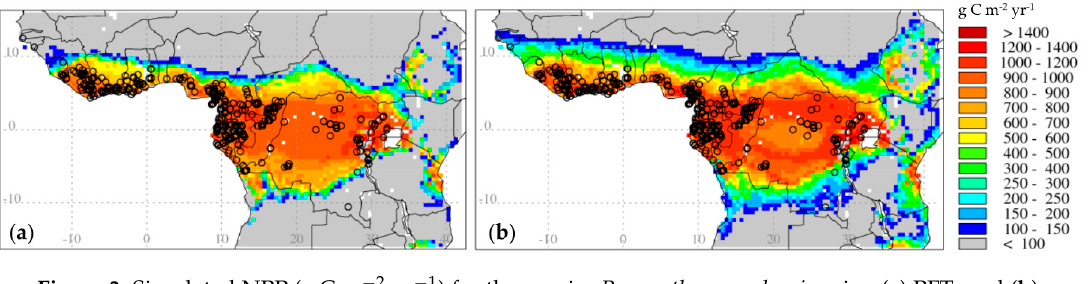
Figure 3. Simulated NPP (g C m − 2 yr − 1 ) for the species Pycnanthus angolensis using ( a ) PFT- and ( b ) species-specific traits. The grey color corresponds to simulated NPP values below the 100 g C m − 2 yr − 1 threshold and the black circles to occurrence data [55,56]. Simulations were obtained with CRU historical climatic data for the reference 1980–1999 period. Table 4. Observed species occurrences, species distribution area (10 6 km 2 ) delimited by the 100 g C m − 2 yr − 1 NPP threshold and sensitivity (proportion of species occurrences correctly predicted by the model) for both simulations using respectively PFT- and species-specific morpho-physiological traits. Simulations were obtained with CRU historical climatic data for the reference 1980–1999 period.